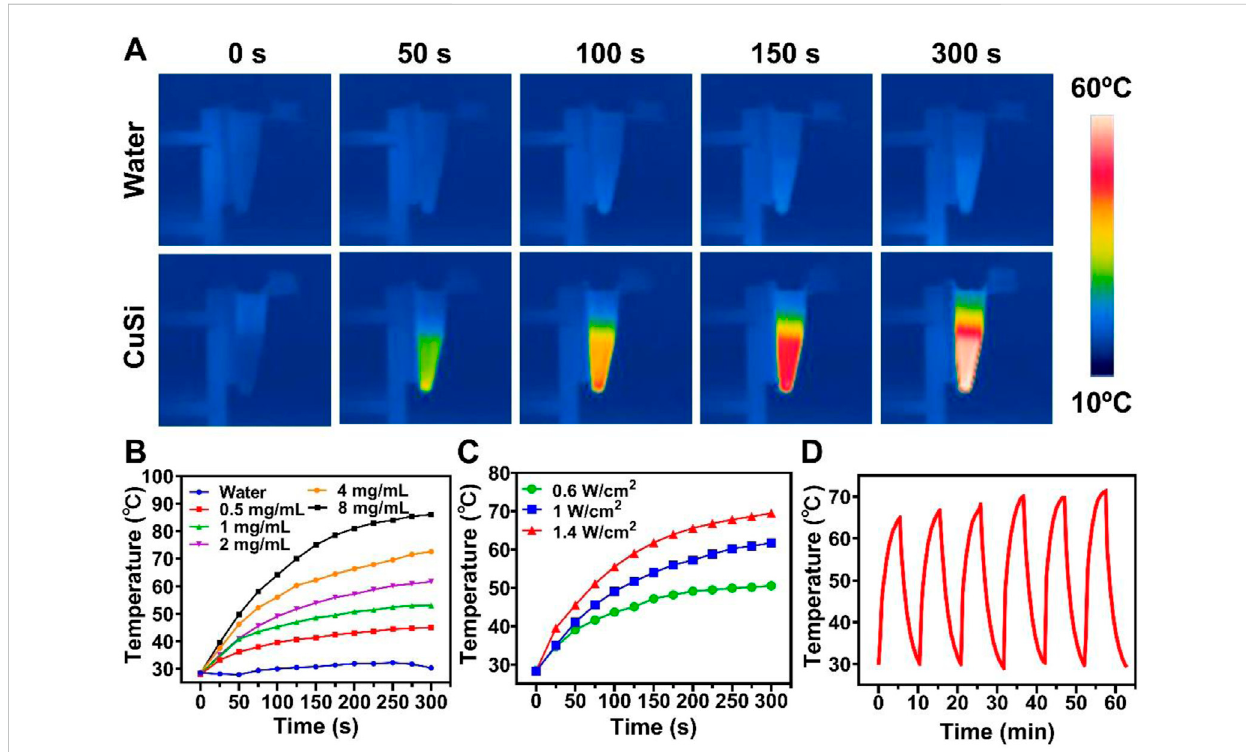
FIGURE 3 Light-to-heatconversioncapabilityof CuSi NWs. (A) Representative thermal images ofwater and CuSi NWs aqueous dispersions under the808 nm laserirradiation. (B) Photothermalheating(1 W/cm 2 )curvesofdifferentCuSiNWsaqueousdispersionsfor5 min. (C) PhotothermalheatingcurvesofCuSi NWs aqueous dispersion (2 mg/mL) under 808 nm laser irradiation at varying power densities (0.6, 1, and 1.4 W/cm 2 ). (D) Photothermal stability of CuSi NWs aqueous dispersion (six laser on/off